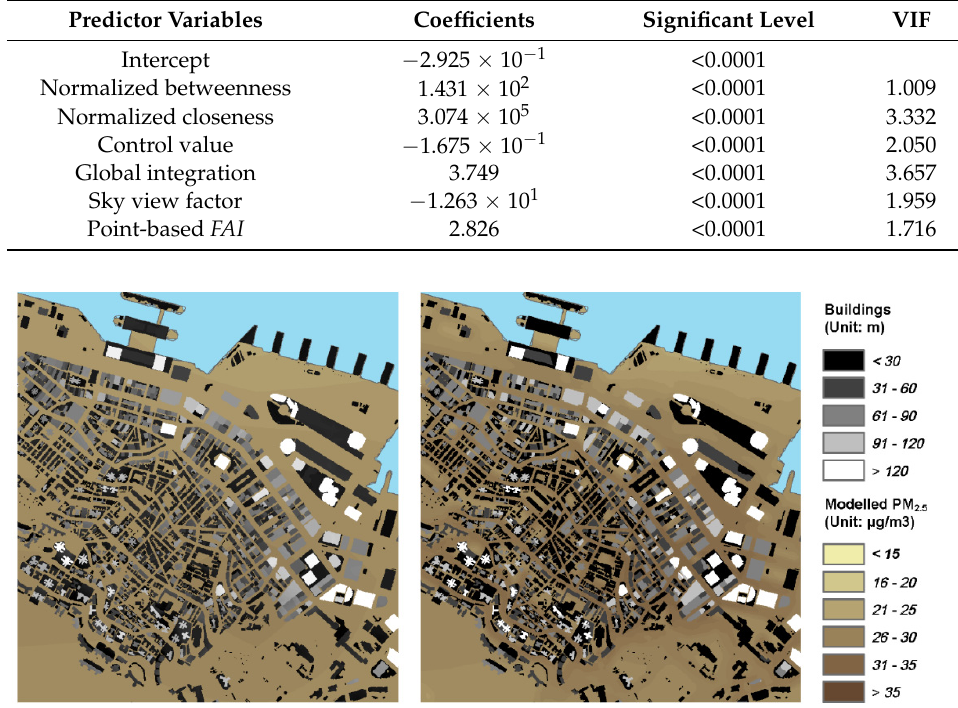
Table 3. Summary of the resultant neighborhood-scale regression model.